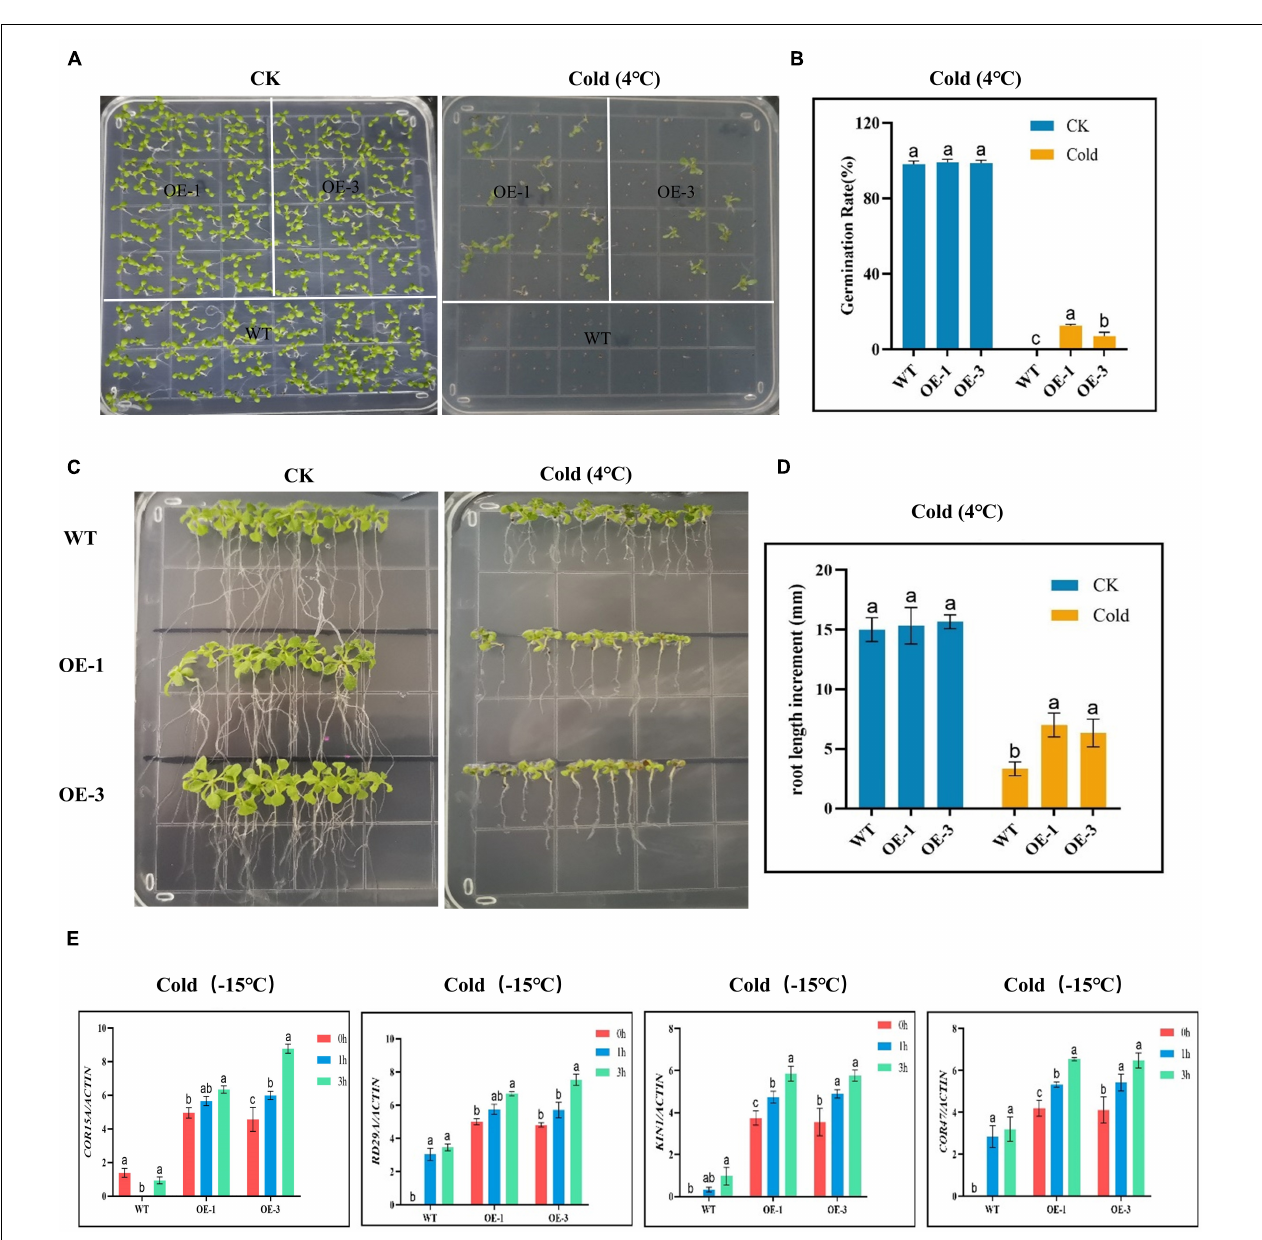
FIGURE 7 | Determination of the growth phenotypes and regulatory gene expression of transgenic Arabidopsis under cold stress conditions. (A,B) Germination rate determination. (C,D) Root length determination. (E) The expression levels of abiotic stress-responsive gene. The letters a/b indicate statistically significant differences (two-tailed, p < 0.05) between the samples in each